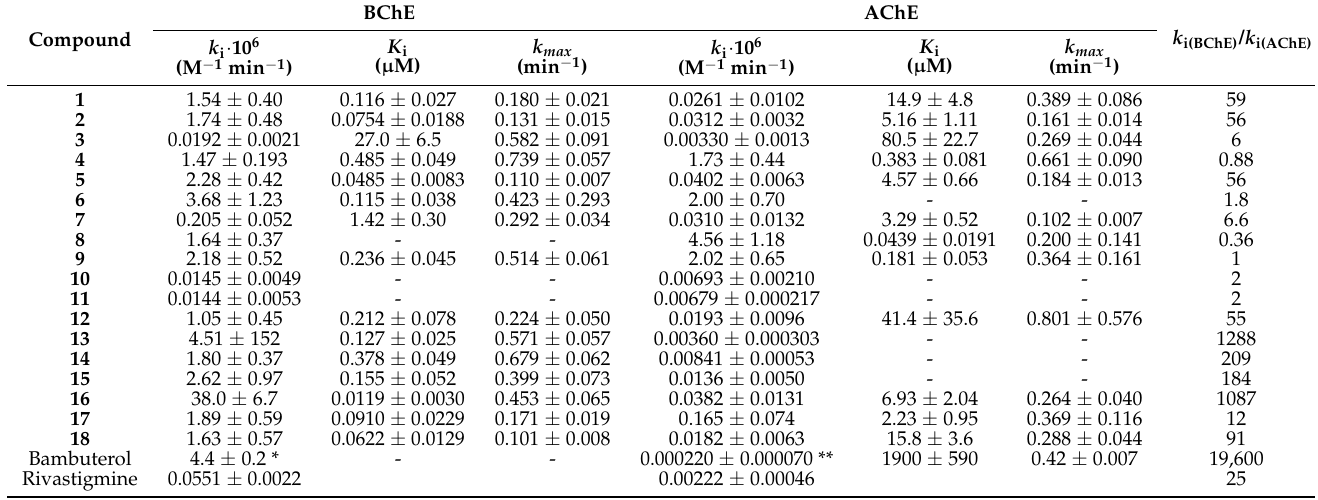
Table 1. Inhibition of acetylcholinesterase (AChE) and butyrylcholinesterase (BChE) by biscarbamates.